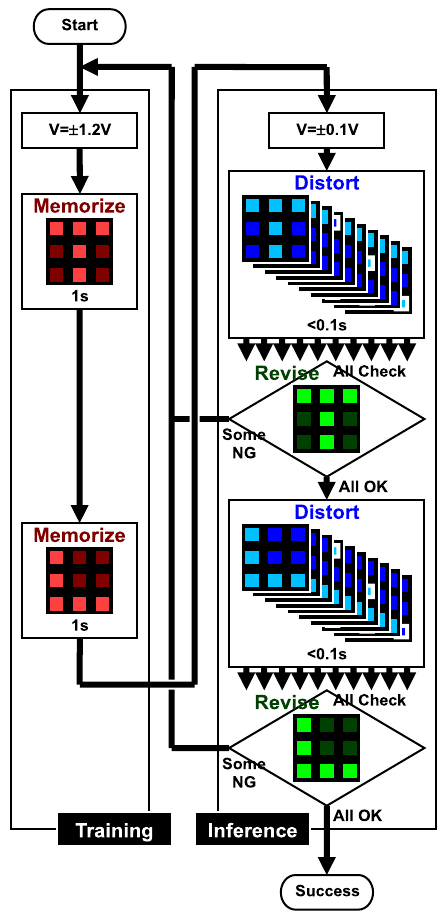
Figure 6. Evaluation flowchart. During the training operation, a relatively high voltage is applied. Two letter patterns are input for some time in sequence. During the inference operation, a relatively low voltage is applied. Slightly distorted patterns are input for a moment, and it is confirmed that the revised patterns are the same as the memorized pattern for all distorted patterns. If the revised pattern is different from the memorized pattern, the flowchart is